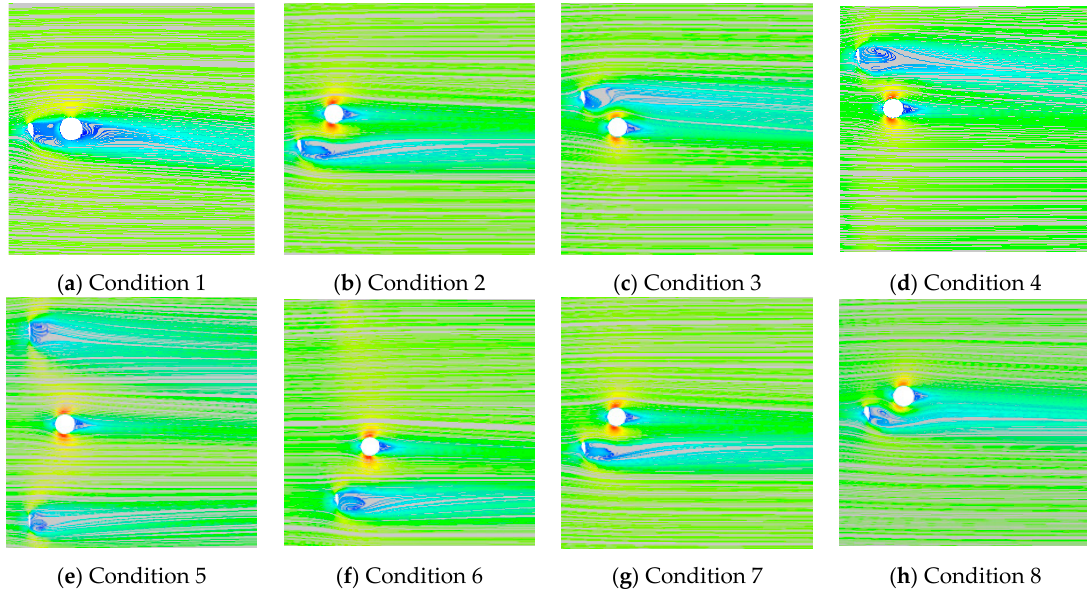
Figure 19. Wind speed streamlines of the disturbed zone.